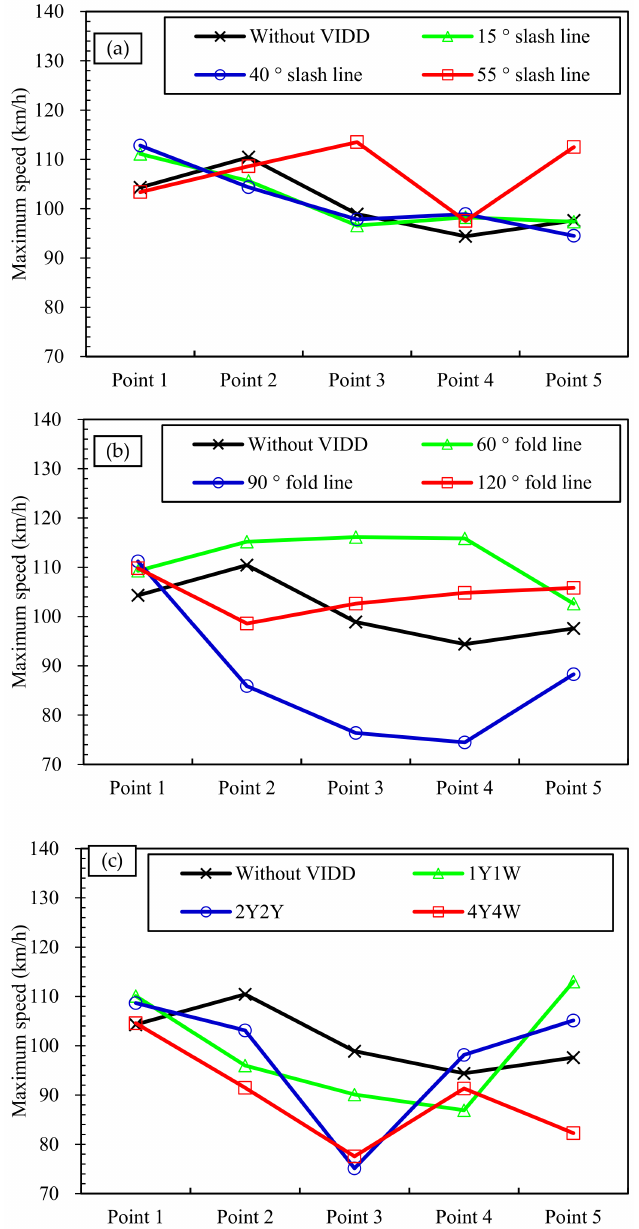
Figure 14. Maximum speeds of vehicles controlled by VIDD: ( a ) slash lines; ( b ) fold lines; ( c ) alternating yellow and white lines.